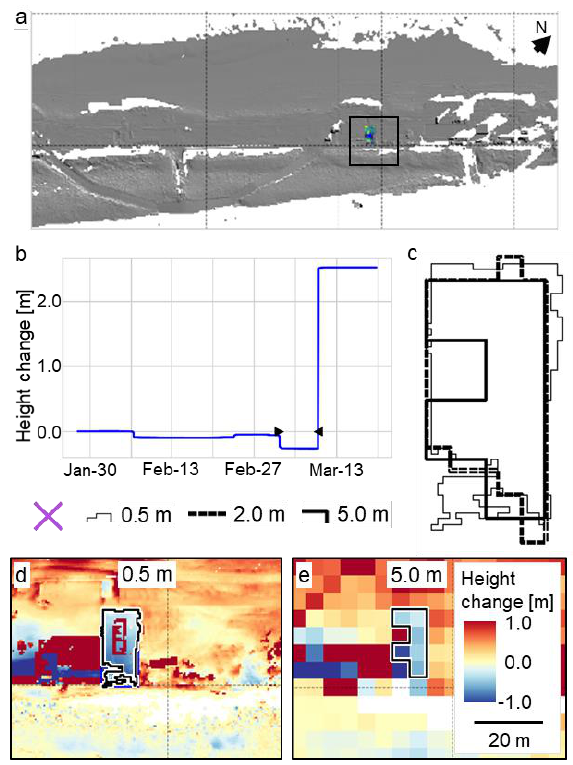
Figure 7. Results for an example 4D object-by-change using reduced spatial resolutions of 2.0 m and 5.0 m. The location on the beach is depicted in the map (a; rectangle marks extent of d and e). The change period is marked by arrow heads in the time series of change values at the seed location (b). Spatial delineations for different input resolutions (c) deviate from the reference by -7 % for 2.0 m and -20 % for 5.0 m resolution. The purple cross below subfigure b depicts the marker used for the object in subsequent figures. Maps of height changes show the delineated change form at reduced resolutions (d and e).